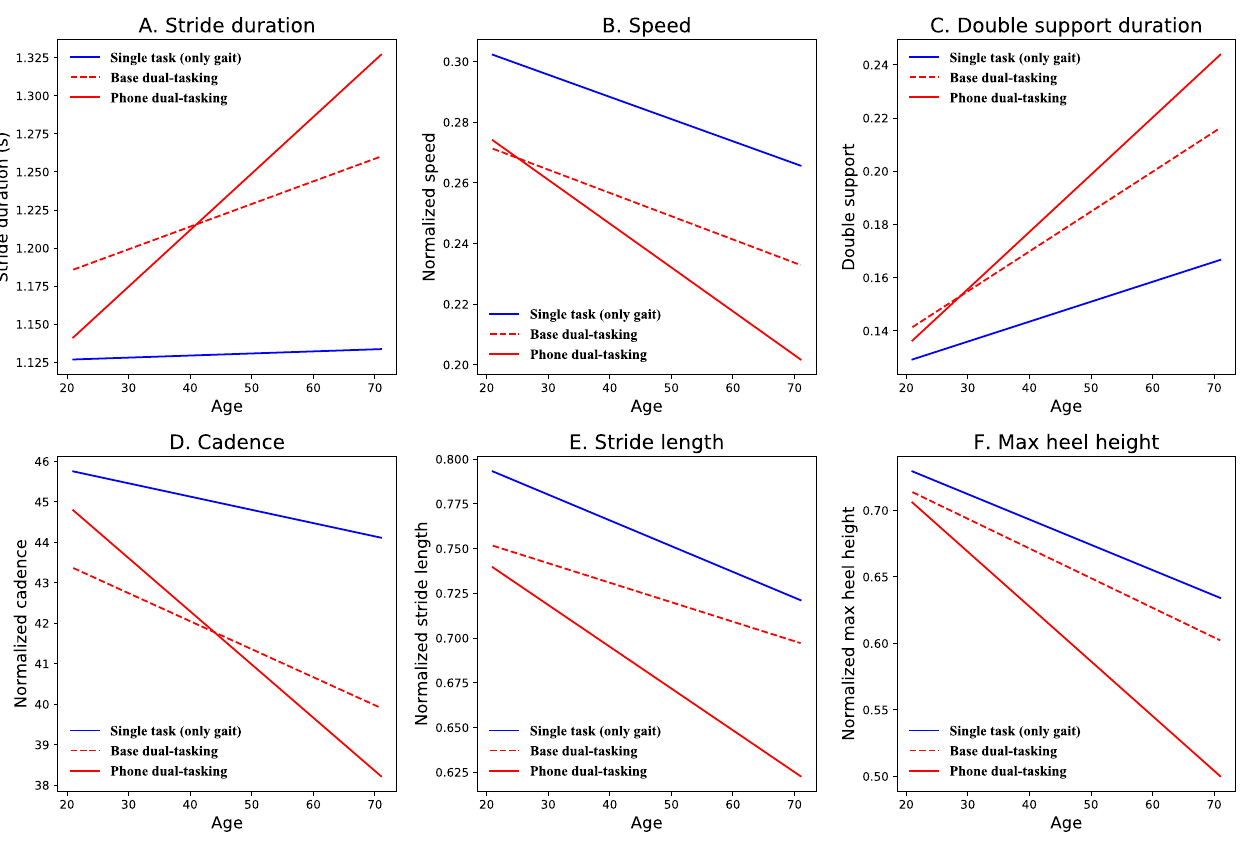
Figure 6. Associations of age (in years) with the normalized gait parameters that showed the best correlation results (see Appendix A, Table